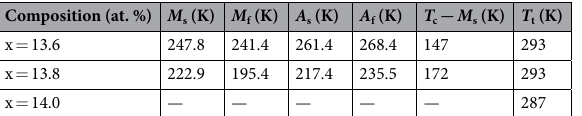
Table 1. Phase transition temperatures ( M s , M f , A s , A f ) from ther M – T measurements, the interval between the Curie and MT temperatures ( T c − M s ), and the testing temperature T t for the isothermal